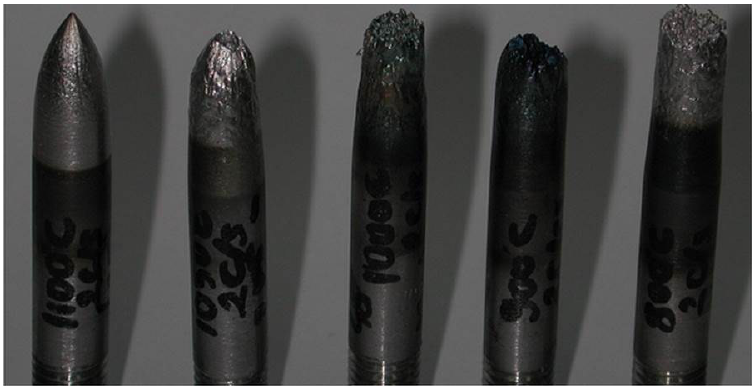
Figure 3. Some of the broken pieces of specimens after hot tensile